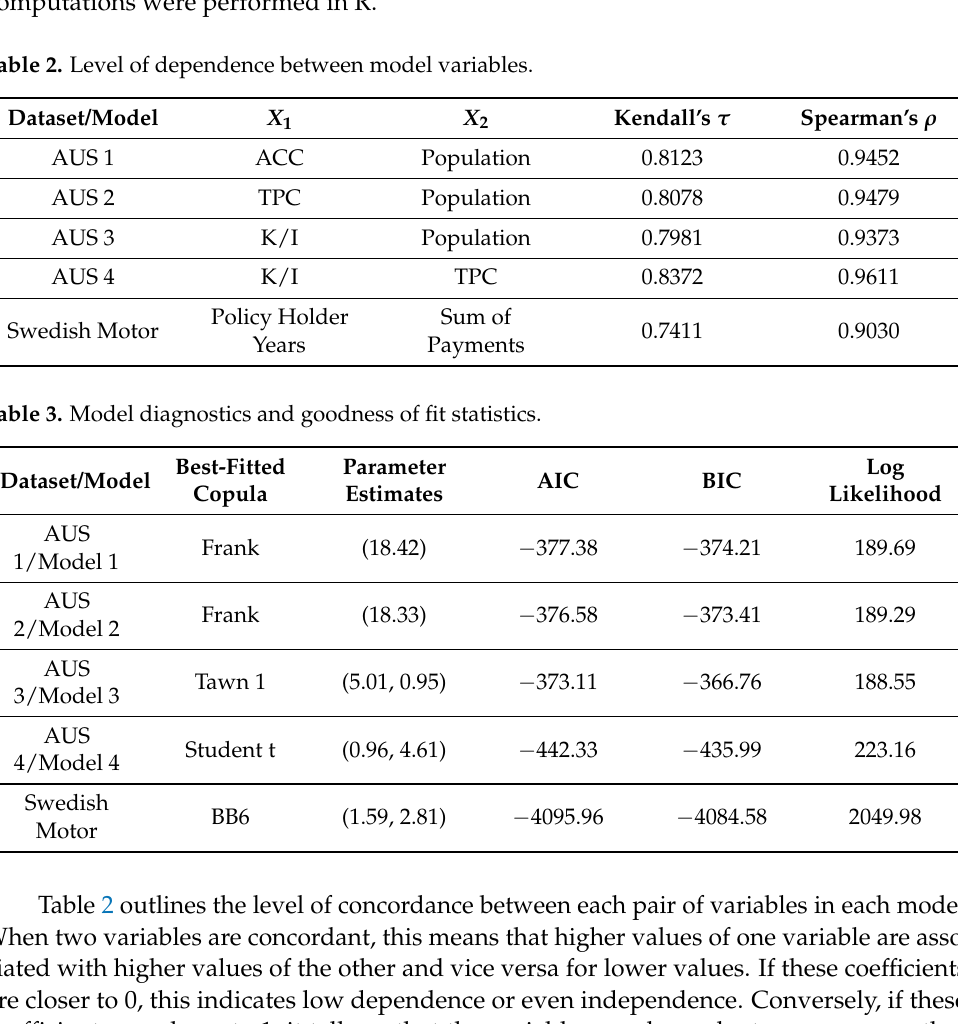
Table 2 outlines the level of concordance between each pair of variables in each